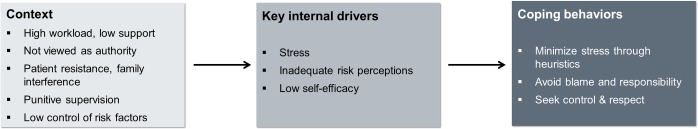
Contextual influences on staff nurse drivers of behavior and associated coping behaviors, as distilled from immersions and responses to decision-making game scenarios.